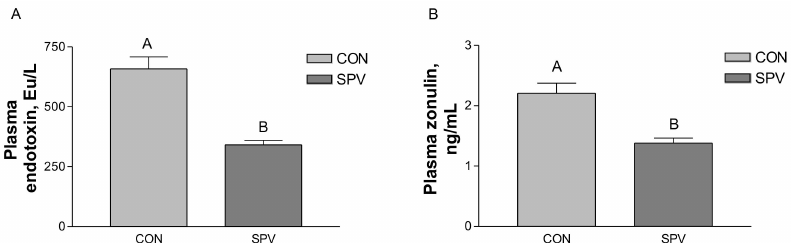
Figure 1. E ff ect of sweet potato vine treatment on plasma endotoxin ( A ) and zonulin ( B ) concentration in Meishan gilt. Values are mean ± SEM (n = 8). CON, gilts fed the basal diet; SPV, gilts fed basal diet with sweet potato vine. A, B Means not sharing identical superscripts in the same figure are significantly di ff erent ( p < 0.01).